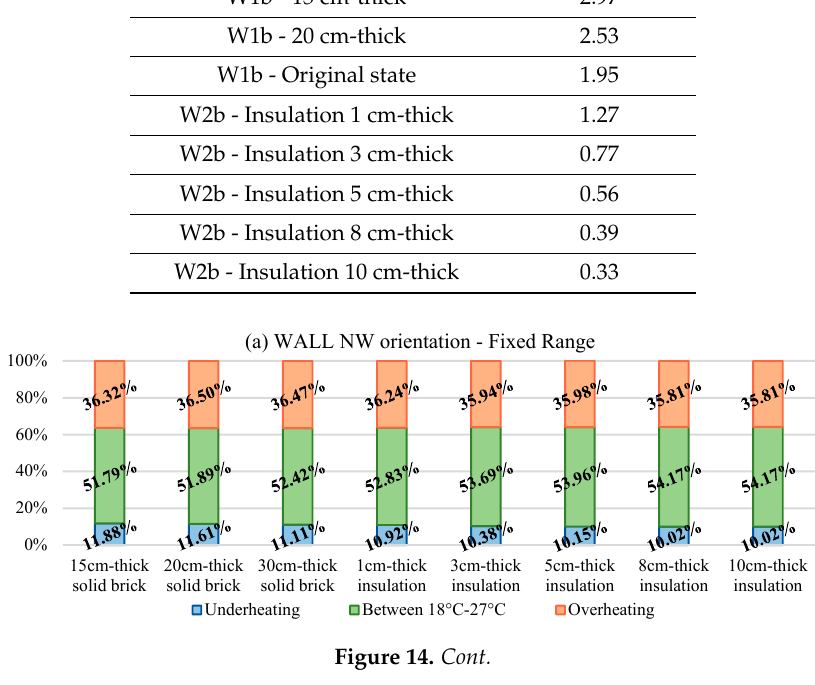
Table 12. Thermal transmittance of wall W2 with NW orientation according to the insulation thickness used.